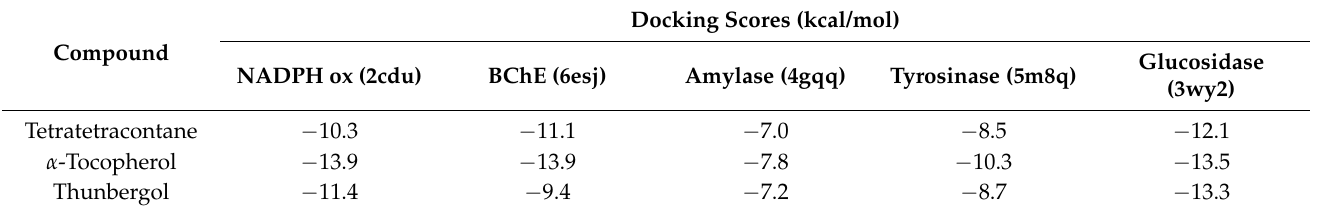
Table 5. The docking scores of tetratetracontane, α -tocopherol, and thunbergol on the active sites of the enzymes BChE, amylase, NADPH oxidase, tyrosinase, and